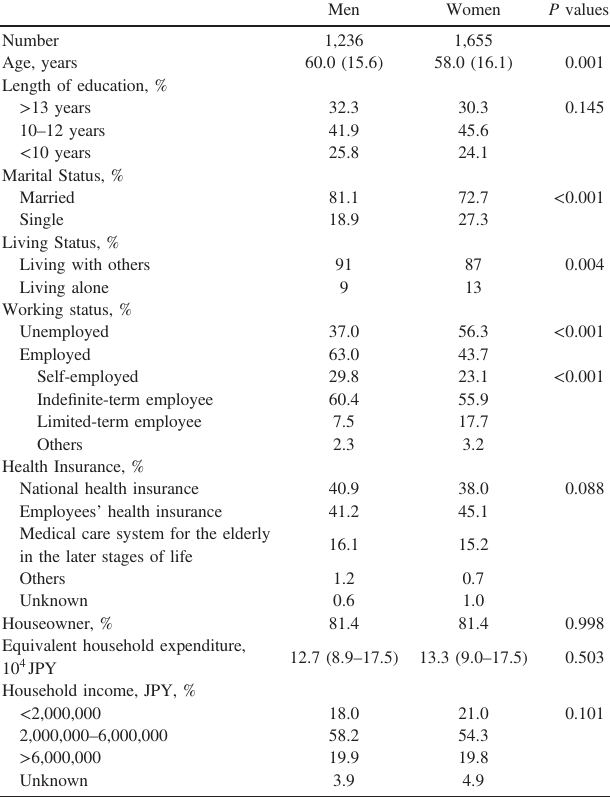
Table 3A. Physical characteristics of participants: NIPPON Table 3B. Socioeconomic characteristics of participants: DATA2010 baseline (1,236 men and 1,655 women)